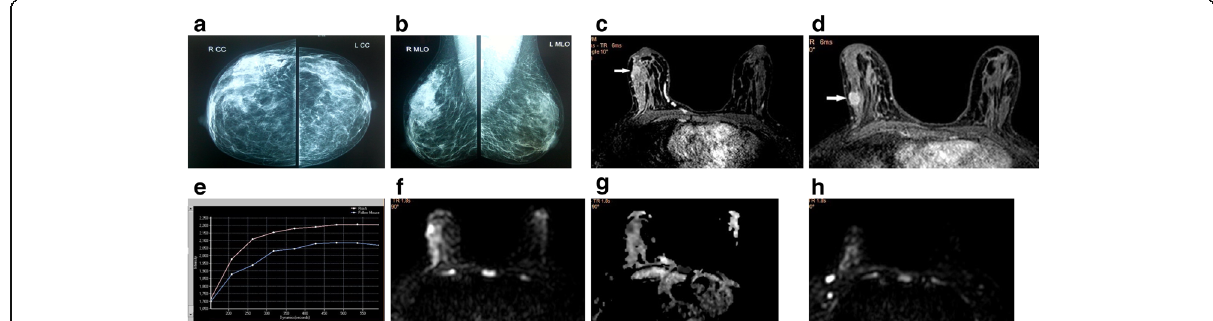
Fig. 7 A 42-year-old female patient with breast lump in the upper outer quadrant of the right breast. Mammography craniocaudal ( a ) and mediolateral obliquel ( b ) views show focal asymmetry in the right upper outer quadrant, associated with pleomorphic microcalcifications (BIRADS IV lesion). Axial TI contrast-enhanced fat-suppressed image on dynamic sequence shows an intensely enhancing irregular right breast mass (arrow) surrounded by segmental area of increased parynchemal enhancement ( c ). Another smaller enhanced well-defined regular mass (D) seen posteroinferiorly (arrow) to the previous mass, suggesting multicentric carcinoma. Dynamic time-intensity curve ( e ) shows type II “ plateau ” curve. The lesion shows hyperintense signal in DWI ( f ) denoting restricted diffusion, and low signal on ADC map ( g ) with measured ADC value 0.56 × 10 – 3 mm 2 /s. Restricted diffusion of the ipsilateral axillary lymph nodes ( h ) with low ADC value 0.67 × 10 – 3 mm 2 /s. MRI findings: BIRADS V lesion.